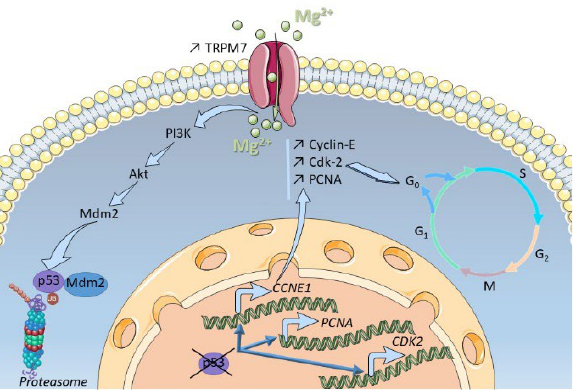
Figure 8. Overview of the pathway activated by TRPM7 and magnesium in PSCs.